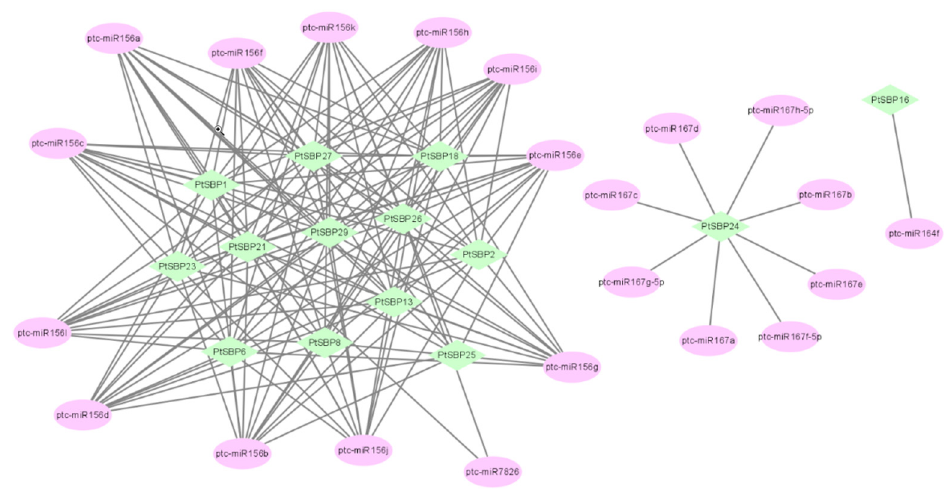
Figure 7. Analysis of the targeting relationship between PtSBP and miRNA. The green icon represents PtSBP , and the pink icon represents the poplar miRNA.